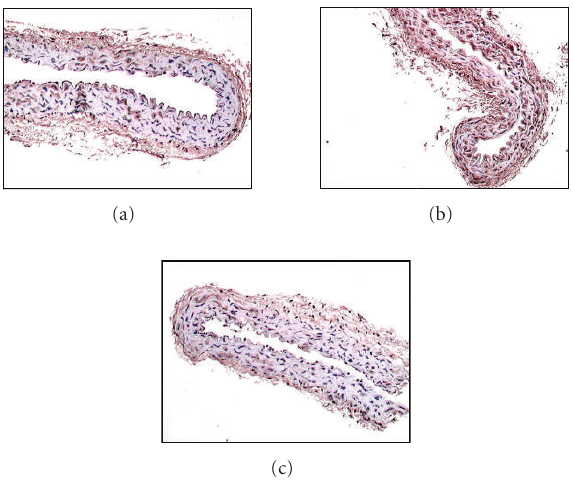
Figure 3: Cross-sections of aorta stained for the NAD(P)H oxidase subunit, p47phox. ApoE KO mouse aorta from (a) control, (b) dia- betic, and (c) diabetic + rosiglitazone treated mice.